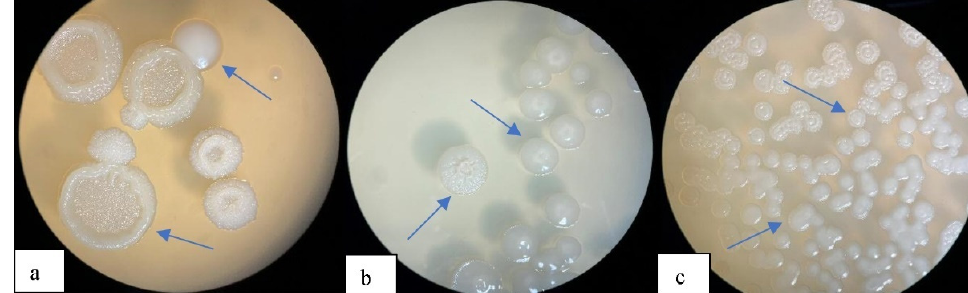
++- 138.3±0.83 *+++ - saturated color; ++- - moderate color; +-- - weak color.